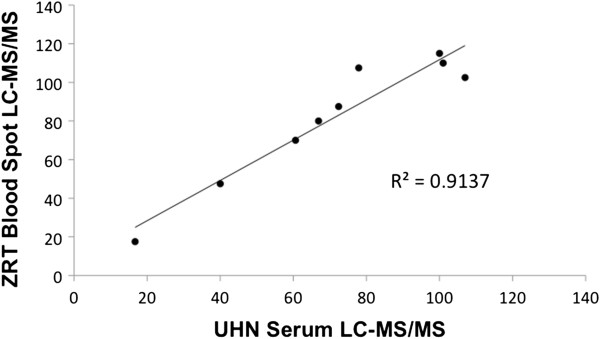
Correlation of 25(OH)D values obtained from serum and blood spots in the same samples.